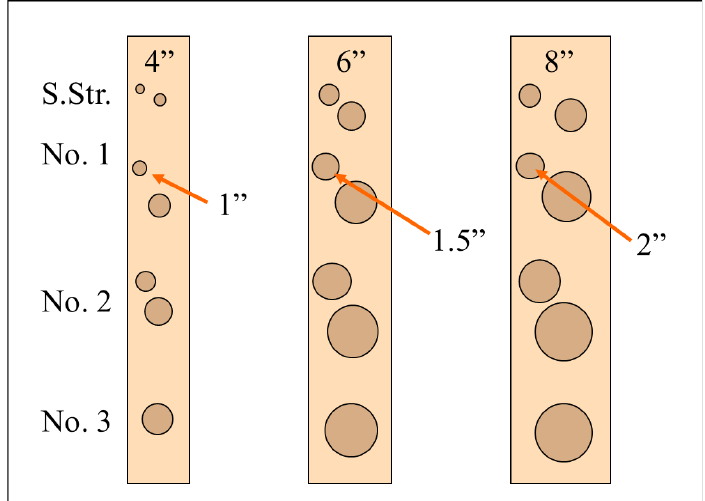
Figure 1. Effect of lumber width and knot size and placement on visually graded dimension